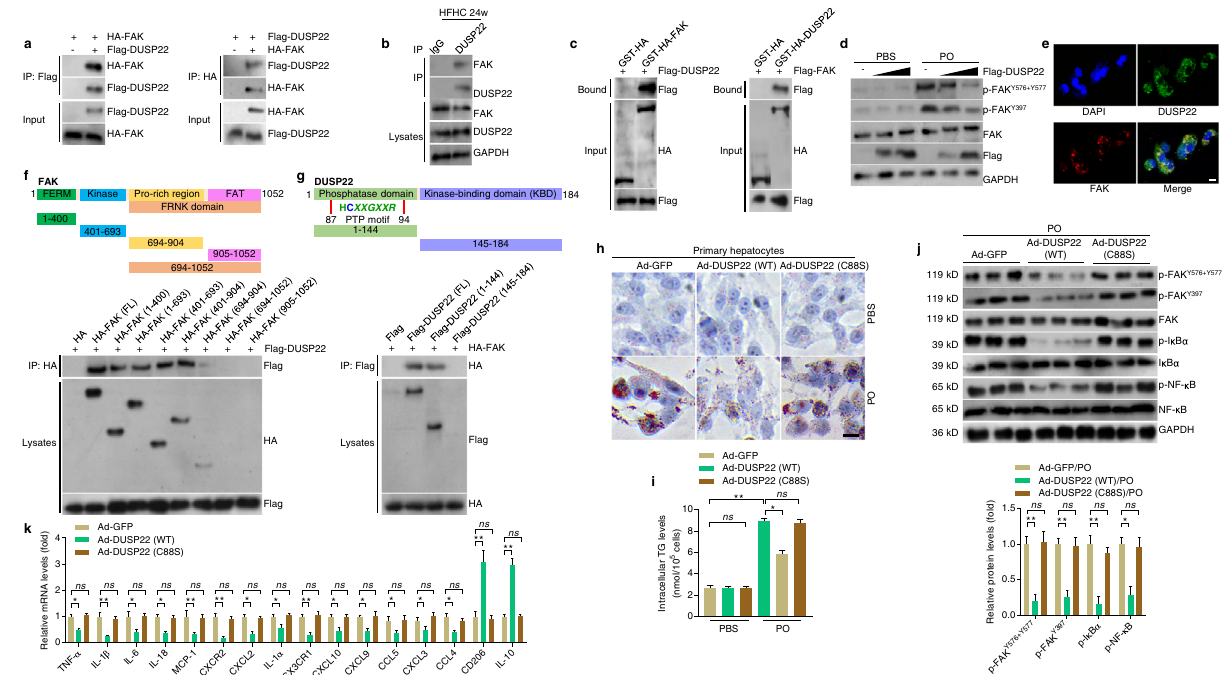
Fig. 5| DUSP22 directlyinteractswithFAK toregulateNASH. a Results by Co-IP assays in L02 cells transfected with Flag-tagged DUSP22 and HA-tagged FAK. Anti- Flag and anti-HA antibodies were used as immunoblotting probes. b Immunoprecipitation and western blotting analysis indicating the binding of DUSP22 and FAK in liver WT mice after a 24-week HFHC, and IgG was served as a control. c GST precipitation analysis presenting the direct DUSP22-FAK binding. Puri fi ed GST wasused as a control. d Representative westernblotting oftotalFAK, p-FAK Y576+577 , and p-FAK Y397 in L02 cells transfected with different amounts of Flag- tagged DUSP22 with PO or BSA treatment for 24h. e Representative immuno- fl uorescent staining of L02 cells co-transfected with Flag-tagged DUSP22 (green) and HA-tagged FAK (red) after transfection for 24h ( n =10 images in total; Scale bar, 10 µ m). f , g Schematic showing full-length (FL) and truncated f FAK (top) and g DUSP22 (top) with representative Co-IP analysis (bottom) for the mapping ana- lysis of the domains responsible for the DUSP22-FAK interaction in L02 cells.